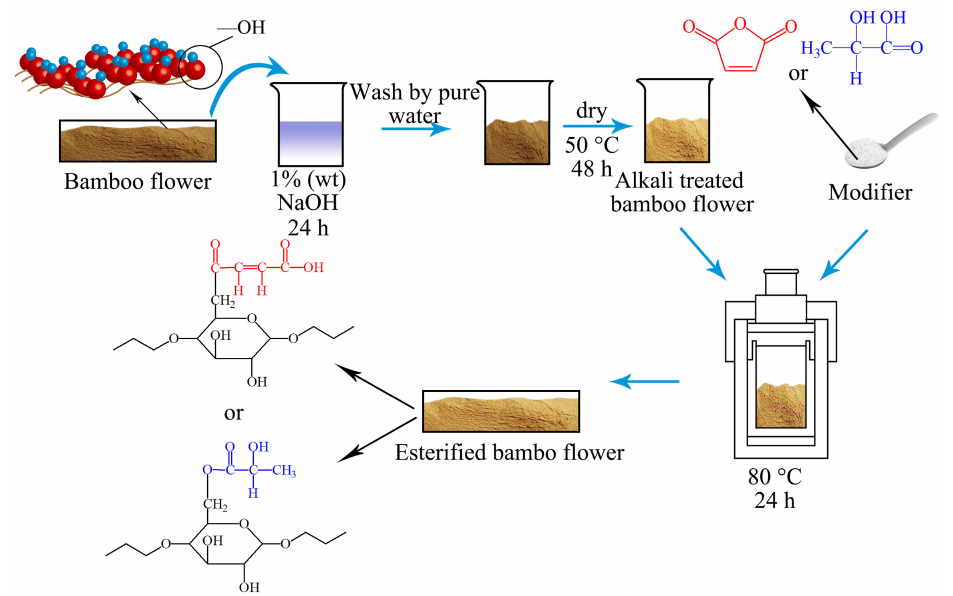
Figure 2. Preparation process of esterified